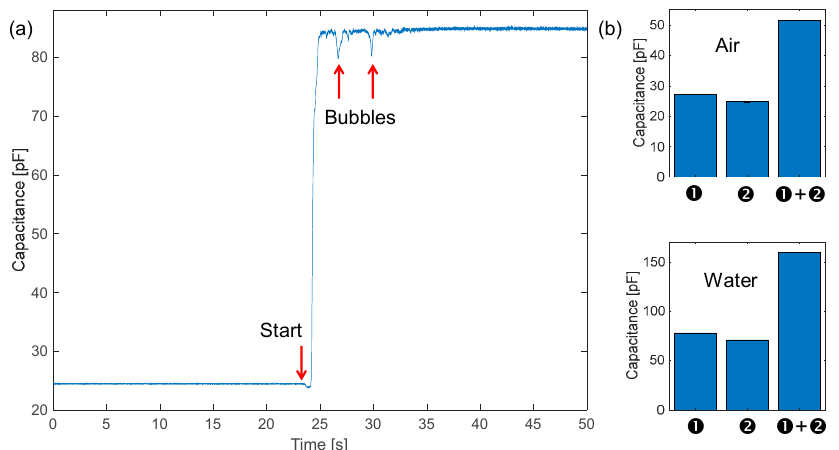
Figure 7. ( a ) Dynamic time tracking of capacitance at 1 MHz during the filling transient of the pipe. ( b ) Static capacitance measurements with two sets of electrodes (45 cm each), connected individually or in parallel (90 cm + ) doubling the signal in two static cases: empty (air) and full (water).